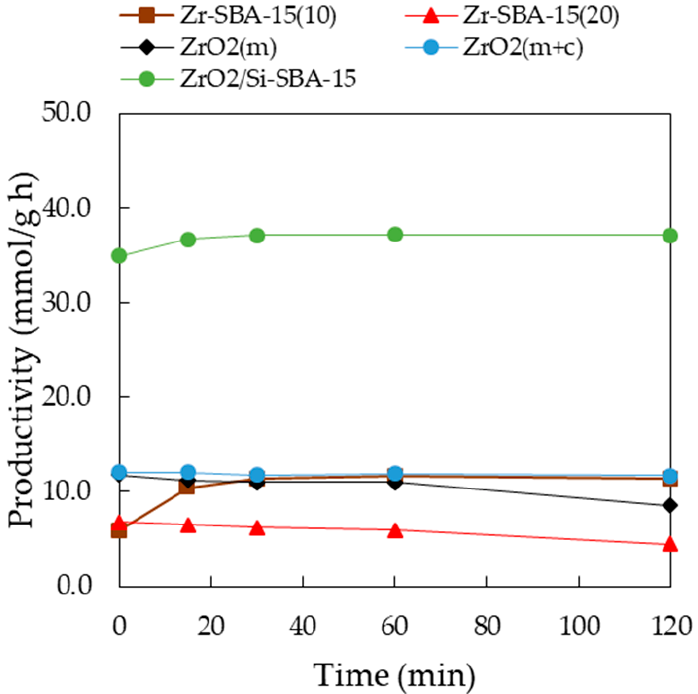
Figure 4. GVL Productivity obtained using the different zirconium materials investigated in the continuous ML hydrogenation. Reaction conditions: 0.1–0.2 g of catalyst, 0.2 mol/L ML in 2-propanol, flow rate: 2 mL/min, 30 bar, 200 °C followed during 2 h.